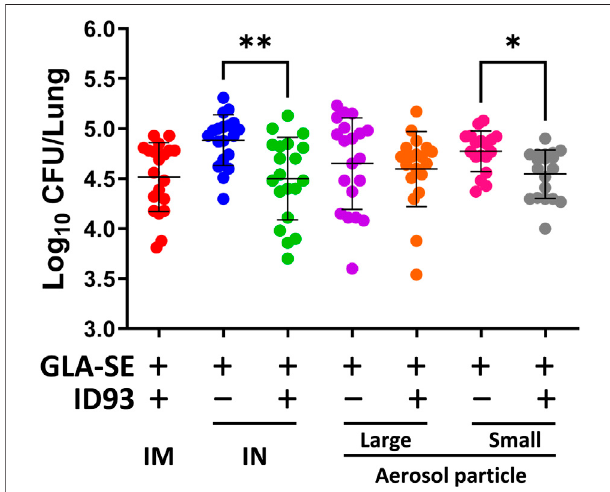
FIGURE 7 | IN delivery of reconstituted liquid ID93+GLA-SE or pulmonary aerosol delivery of small particle size spray-dried powder ID93+GLA-SE confers protection in a mouse model of Mtb . B6 mice (n (cid:1) 18 – 20) were vaccinated with ID93+GLA-SE or only GLA-SE through reconstituted liquid intramuscular (IM), reconstituted liquid intranasal (IN), nasal aerosol delivery of large particle dry powder, or pulmonary delivery of small particle dry powder, at day 0 and day 21. All groups of B6 mice were rested for 4 weeks after which mice were challenged with Mtb H37Rv (100 CFU). Mtb CFU was determined at 4 weeks post-infection. Data presented are combined results from two identical experiments, showing mean ± SD. * p < 0.05 and ** p < 0.01 by one-way Welch ’ s ANOVA with Dunnett ’ s T3 correction for multiple comparisons between selected